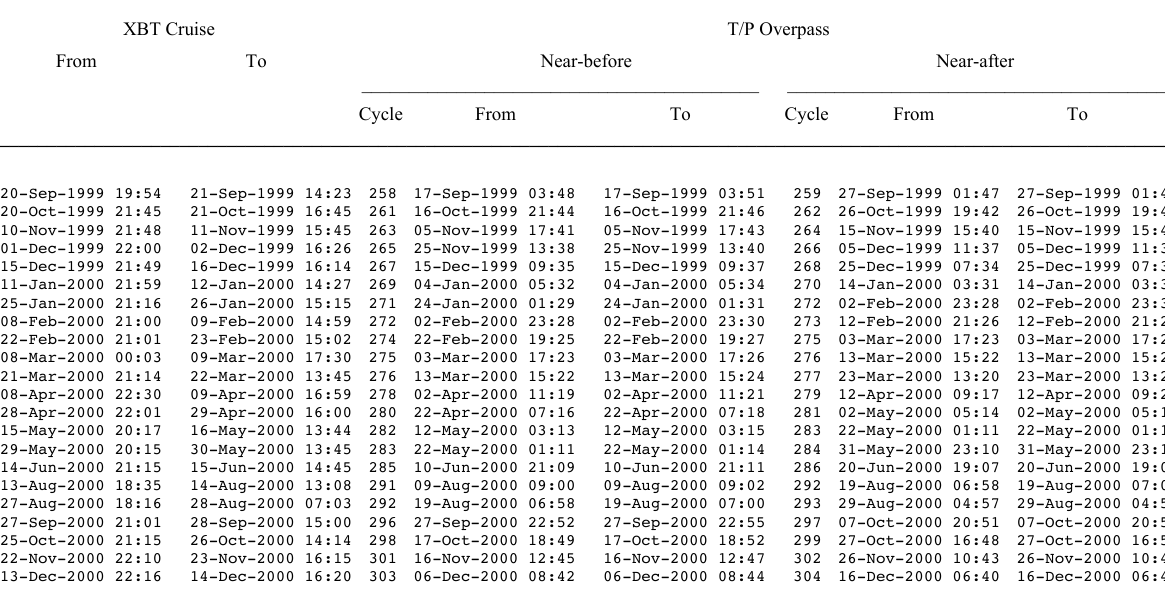
Table 1. XBT cruises (date and time) and near T/P overflights (cycle, date and time) ____________________________________________________________________________________________________________________________ XBT Cruise T/P Overpass From To Near-before Near-after __________________________________________ _________________________________________ Cycle From To Cycle From To _____________________________________________________________________________________________________________________________